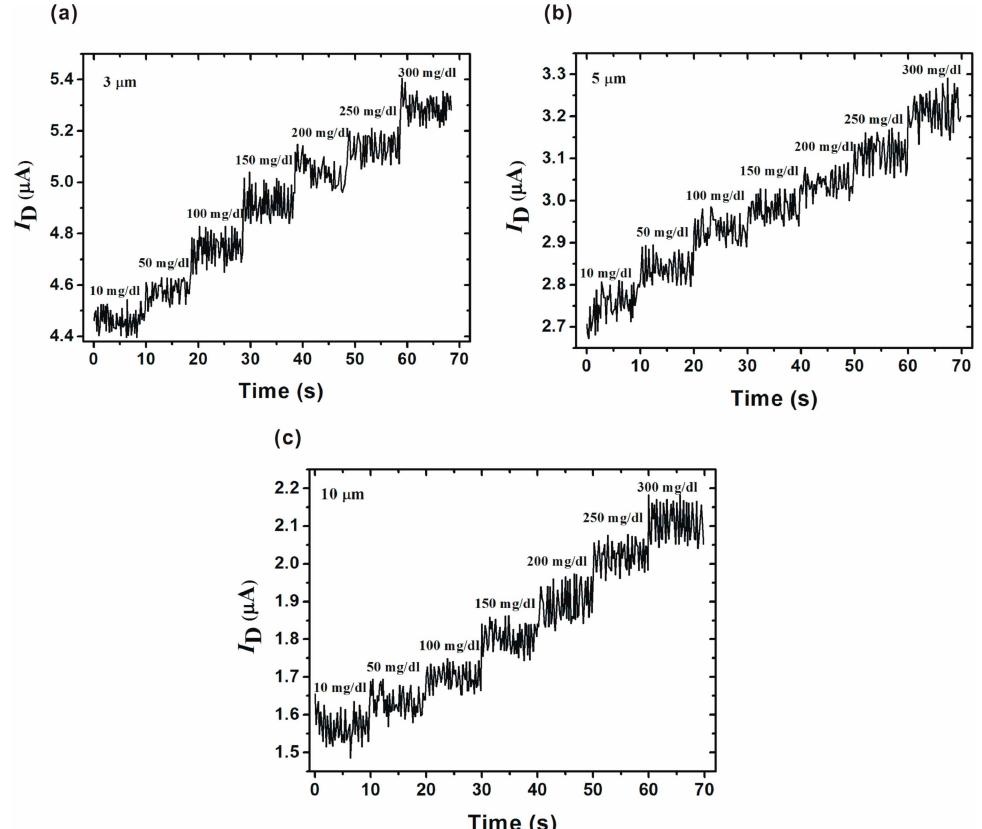
Figure 3. Current-time response curve of the proposed sensor with nanowire lengths of ( a ) 3 µm, ( b ) 5 µm and ( c ) 10 µm.